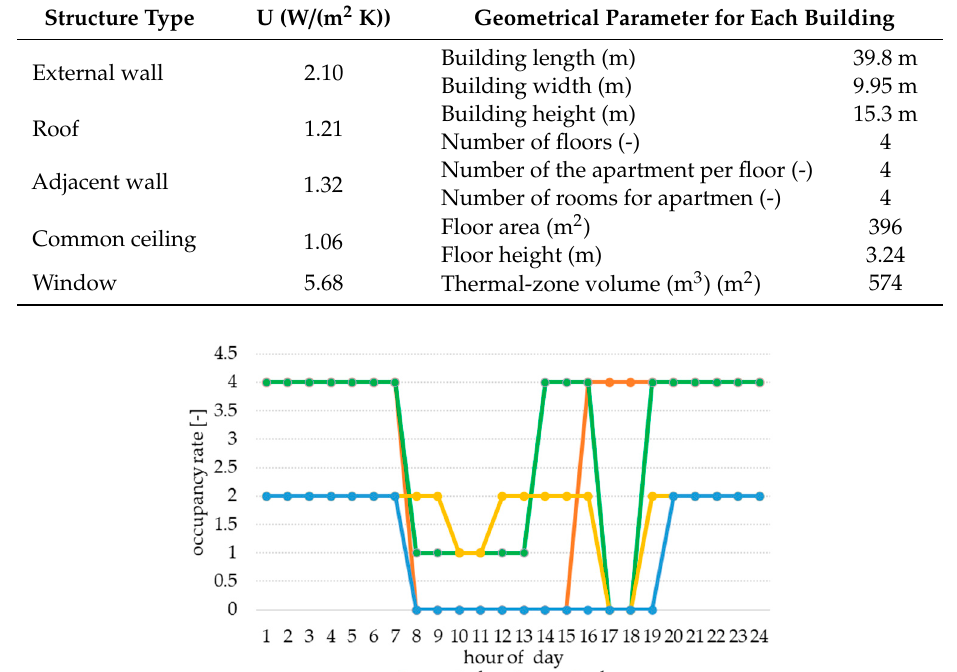
Table 2. Building envelope and geometric parameters. Figure 2. Schedule Figure 2. Schedule occupation.